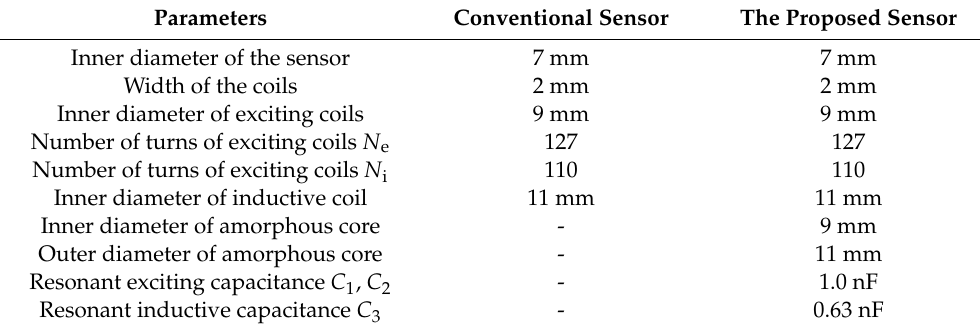
(b) Figure 11. The signal of particles with different speeds. ( a ) The preliminarily extracted particle signals and ( b ) the shaped particle signals. Table 4. The signal-to-noise ratio (SNR) of real signals. Particle Speed (m/s)